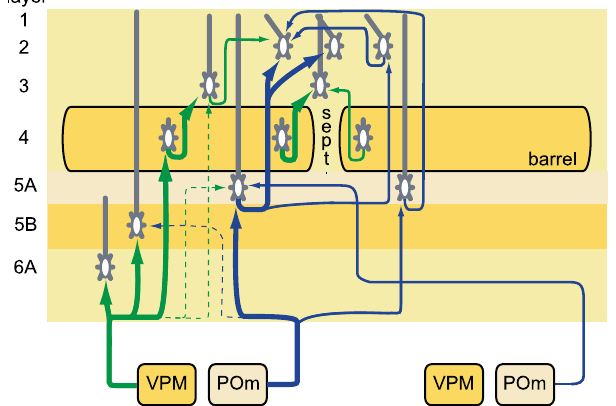
Figure 9. Circuit Diagram of the Thalamocortical and Ascending Intracortical Projections in the Barrel Cortex Lemniscal projections, green; paralemniscal projections, blue. Thick, thin, and dashed lines denote decreasing density of the projection. DOI: